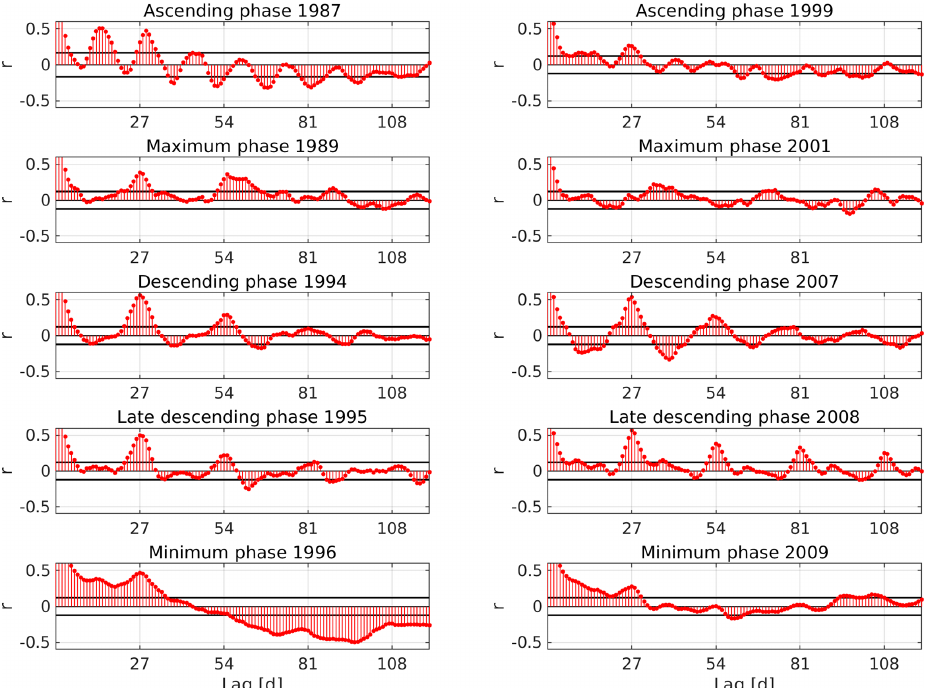
Figure 4. ACFs of electron fluence for different phases of the SC 22 (a) and 23 (b) as a function of lag in days. The horizontal black lines are the CVCs.